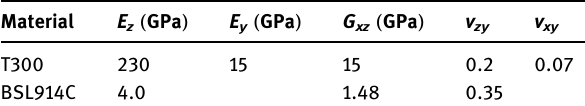
Table 3: Elastic properties of the constituent phases of T300/ BSL914C composites Material